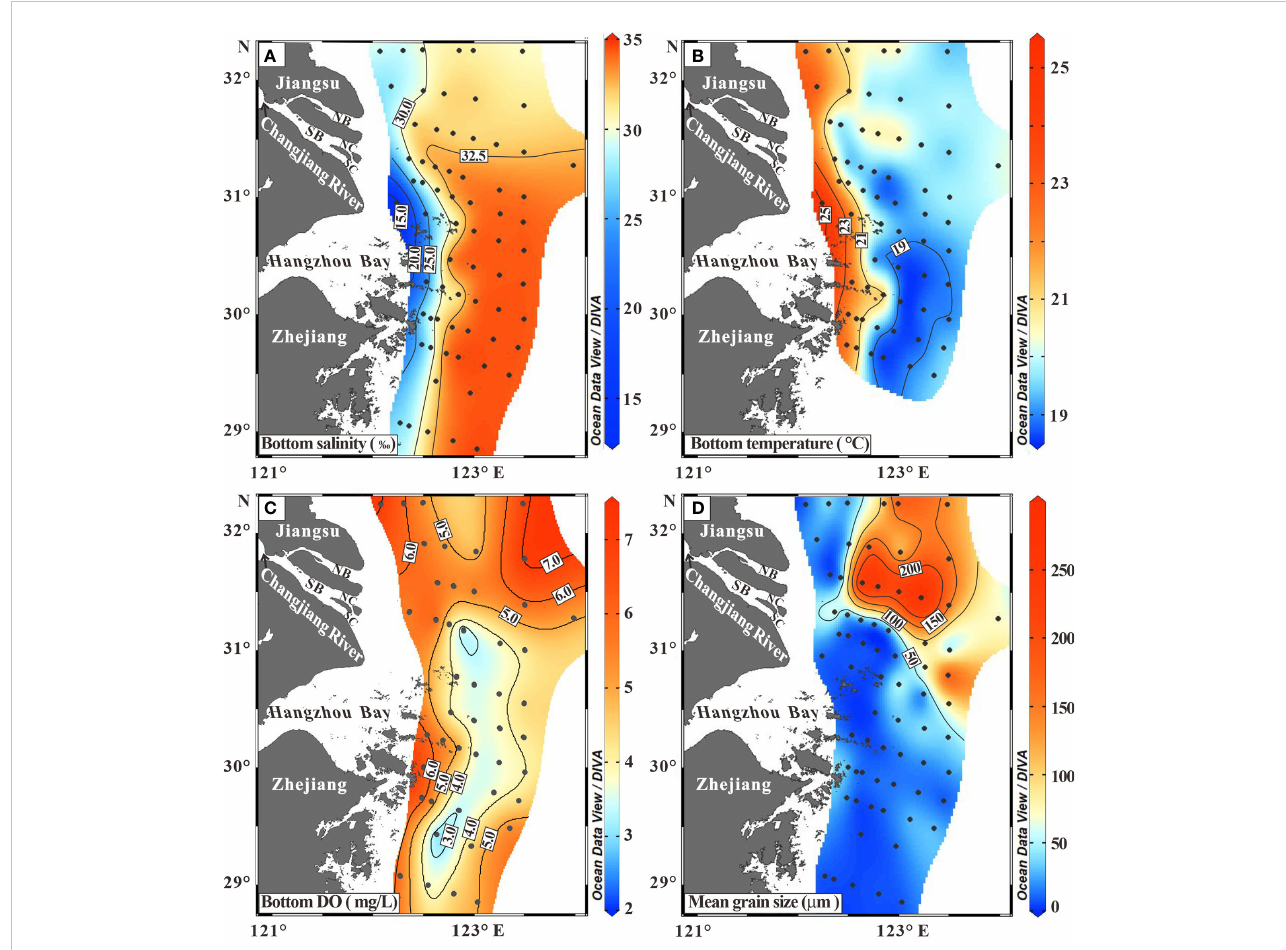
FIGURE 2 Distribution patterns of bottom-water oceanographic indexes including (A) salinity ( ‰ ), (B) temperature (°C), and (C) DO (mg/L), and (D) mean grain size ( m m) of surface sediments. Detailed data are included in Supporting Information Table